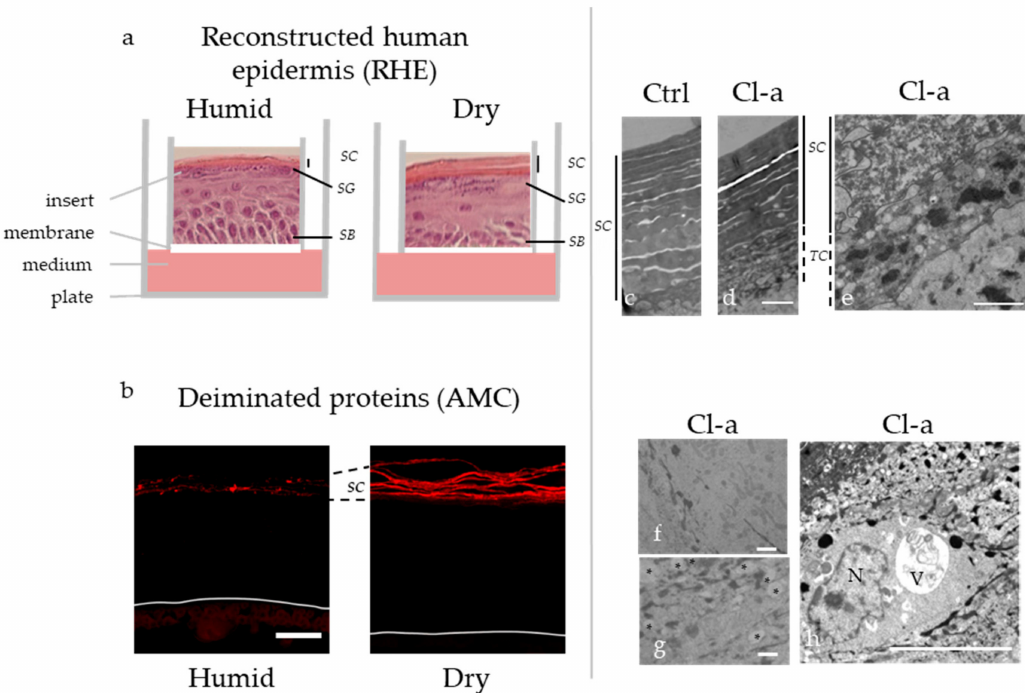
Figure 3. Production of 3D reconstructed human epidermis (RHE) in a dry atmosphere induces deimination while inhibition of deimination by Cl-amidine alters autophagy at the transition stratum granulosum / stratum corneum. ( a ) Schematic representation of the RHE produced in a humid (relative humidity = 95–100%) versus dry (relative humidity around 30%) atmosphere, with hematoxylin-eosin staining of a representative RHE section in each condition. ( b ) Immunofluorescence detection of deiminated proteins with the AMC antibody in RHE produced in a humid or dry atmosphere. Bar = 20 µ m. ( c – h ) Transmission electron microscopy observations of control RHE (Ctrl), and RHE treated with Cl-amidine (Cl-a). The corneocytes and transitional cells are delineated by vertical full or dotted line, respectively ( c – e ). Clustered mitochondria are shown ( f ) and heterogeneous small vesicles are pointed by asterisks ( g ). A large vesicle (V) close to a nucleus (N) with a non-ovoid irregular shape is also illustrated ( h ). Bar = 1 µ m. SB: stratum basale , SC: stratum corneum , SG: stratum granulosum , TC: transitional